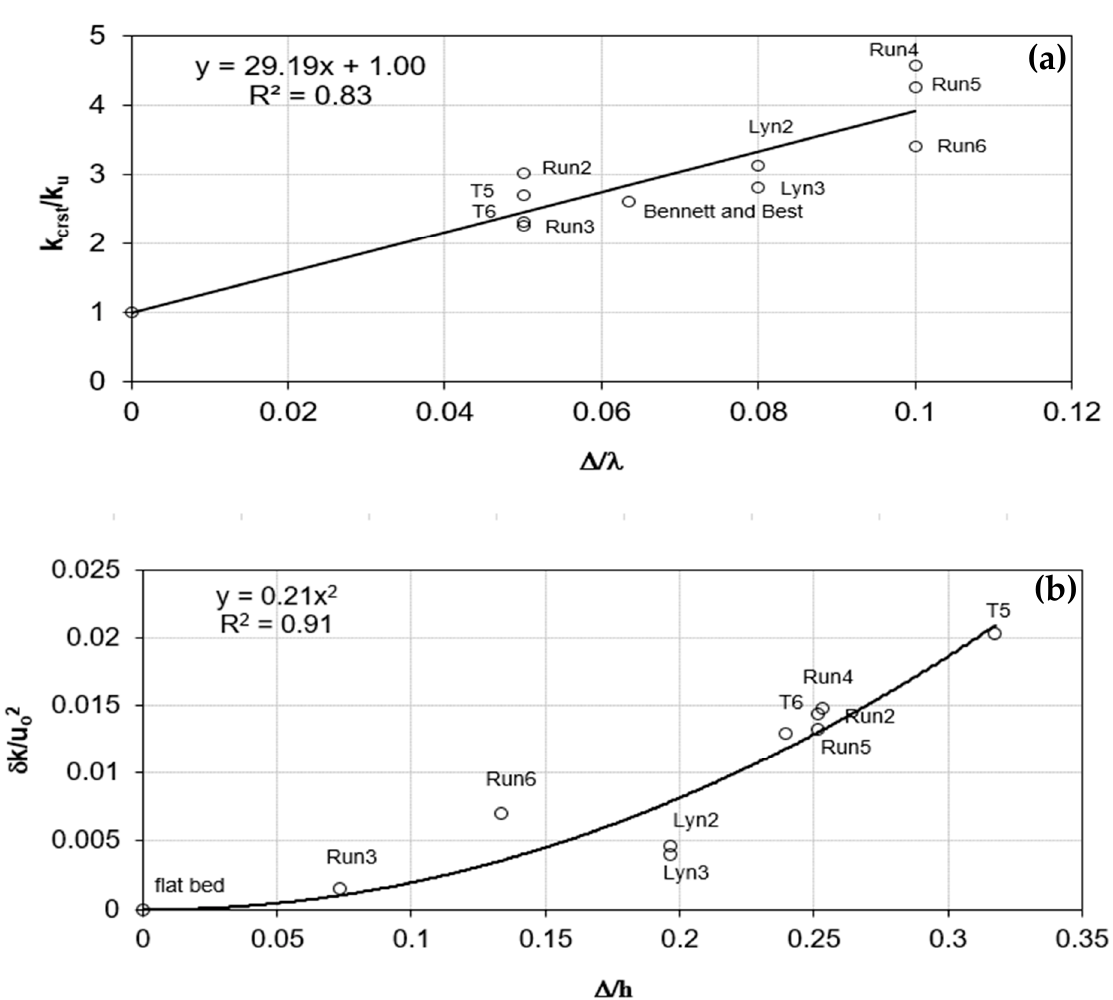
Figure 8. ( a ) Effect of bedform height on the equilibrium value of the depth-averaged turbulent kinetic energy over the crest. ( b ) Effect of bedform height on the net increase in the depth-averaged turbulent kinetic energy, dk , over bedforms (refer to Figure 3 for definitions).